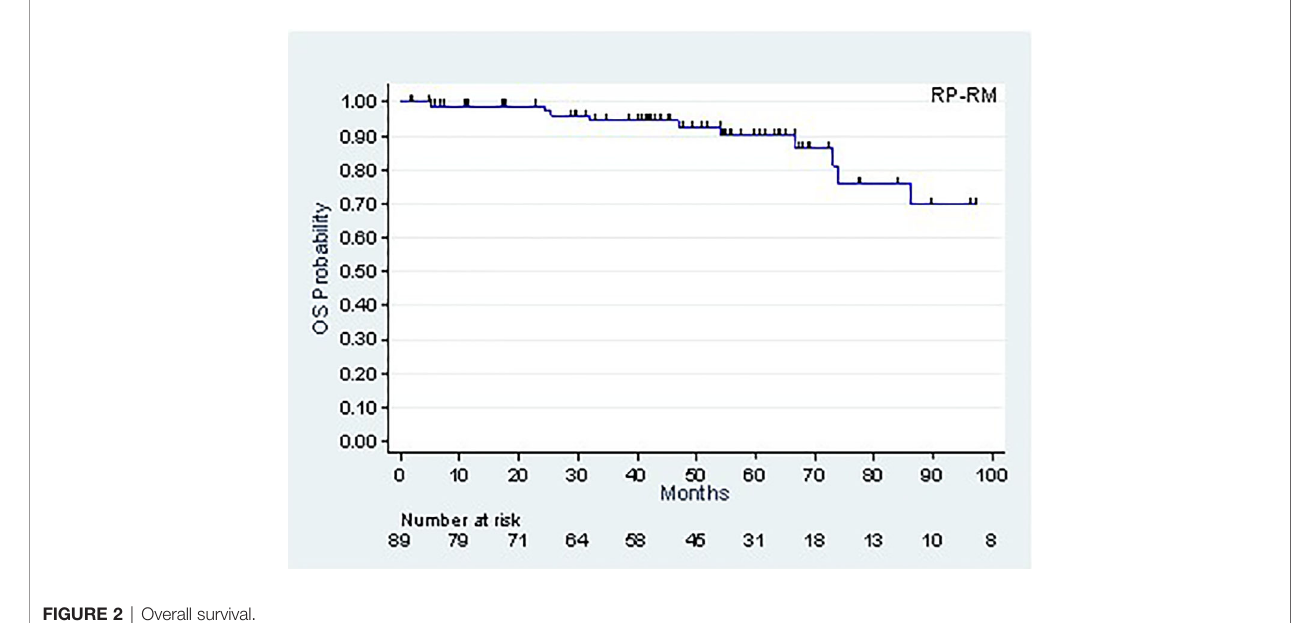
FIGURE 2 | Overall survival.